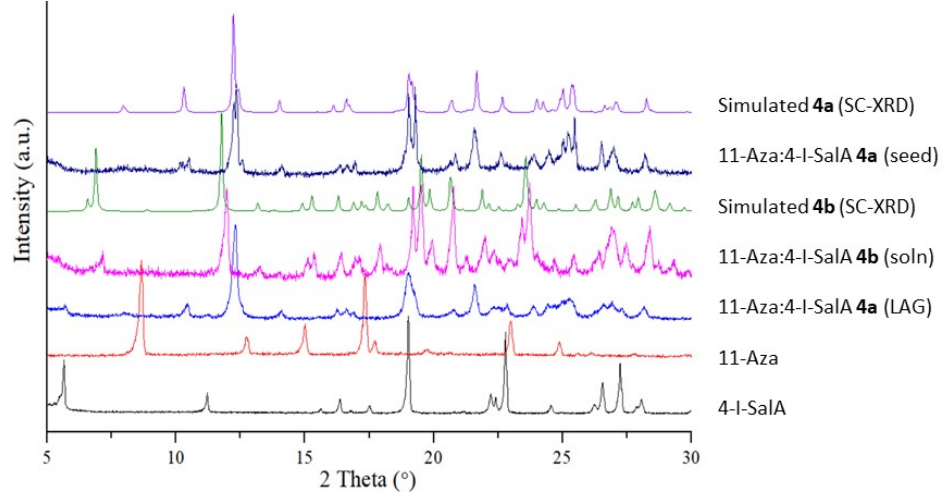
Figure 4. Powder X-ray diffractograms for 4a (from solution growth after hetero-seeding with 1 ) and 4b from LAG along with the coformers 11-Aza and 4-I-SalA.